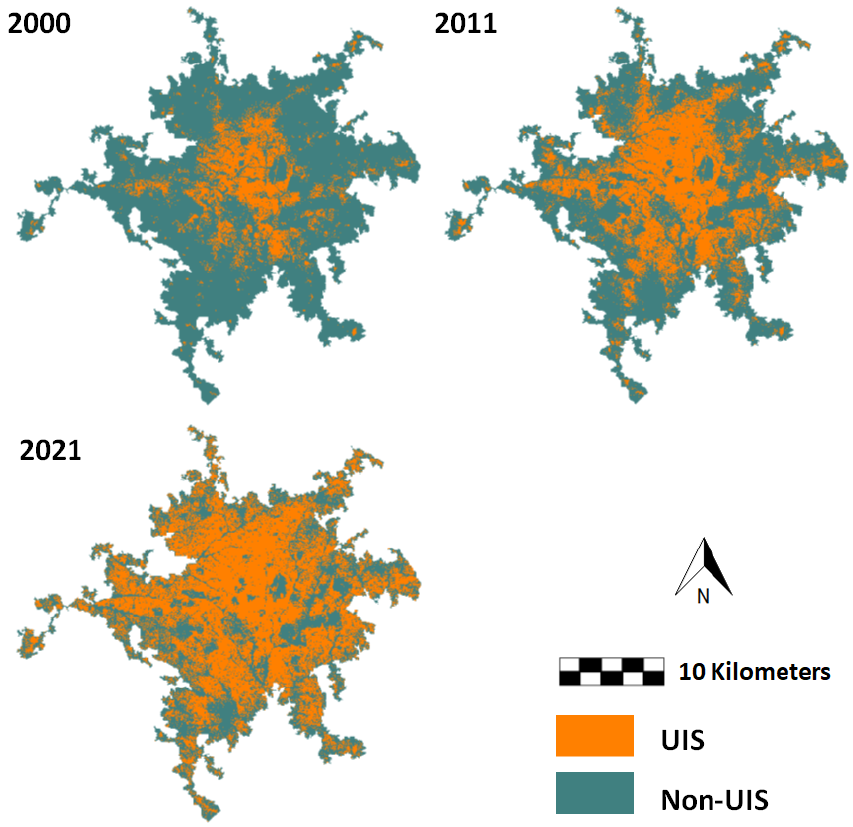
Figure 3. Annual UIS maps for Kumasi in 2000, 2011, and 2021 ( upper left , upper right, and lower left ), respectively.